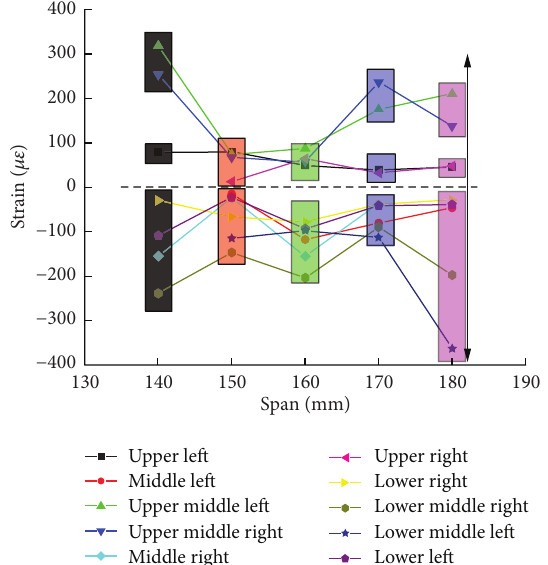
Figure 8: Peak strain at feature points with different